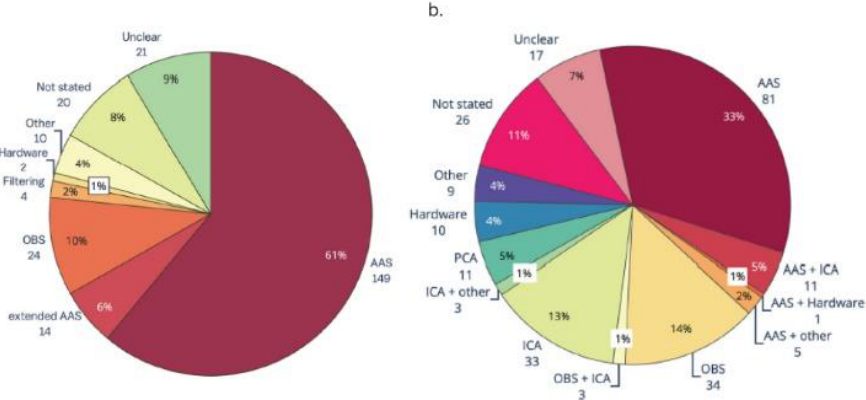
Figure 2. Part ( a ). Gradient artifact removal in EEG-fMRI papers, published between 2016 and 2019 ( n = 244). AAS, average artifact subtraction; OBS, optimal basis set. Part ( b ). Ballistocardiogram (BCG) artifact removal method in literature using EEG-fMRI published between 2016 and 2019 ( n = 244). AAS, average artifact subtraction; OBS, optimal basis set; ICA, independent components analysis; PCA, principal components analysis. Reproduced under open access license agreement CC BY